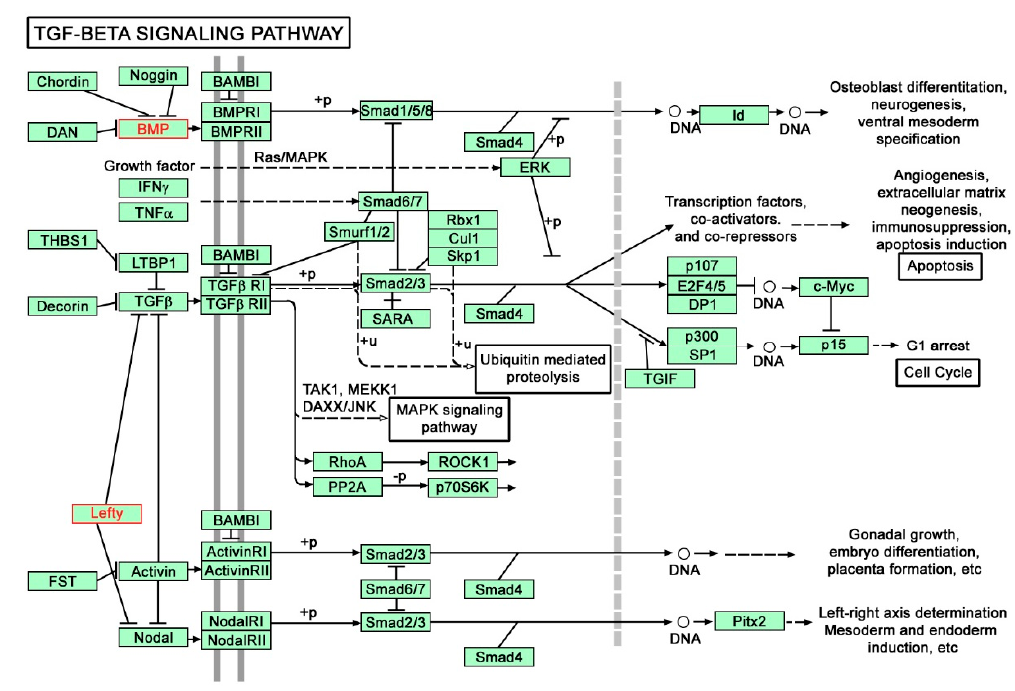
Figure 2. Genes mapping to KEGG pathway for TGF- β signaling pathway (hsa04350) [5] with included LEFTY1 and BMP8B genes (red labels).